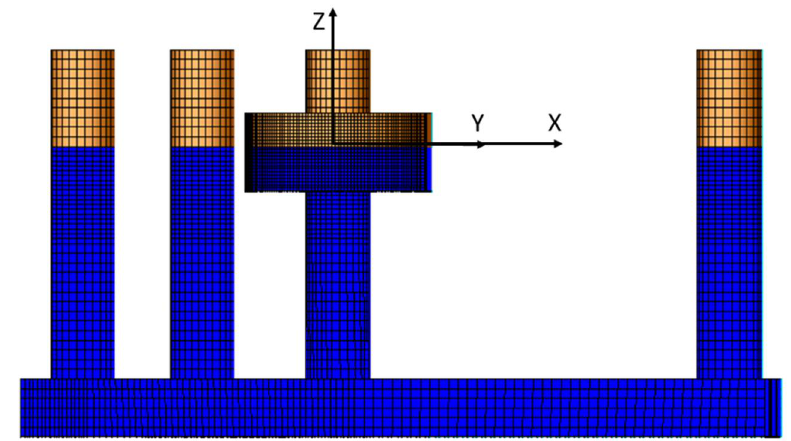
Figure 3. Panel models for the hydrodynamic